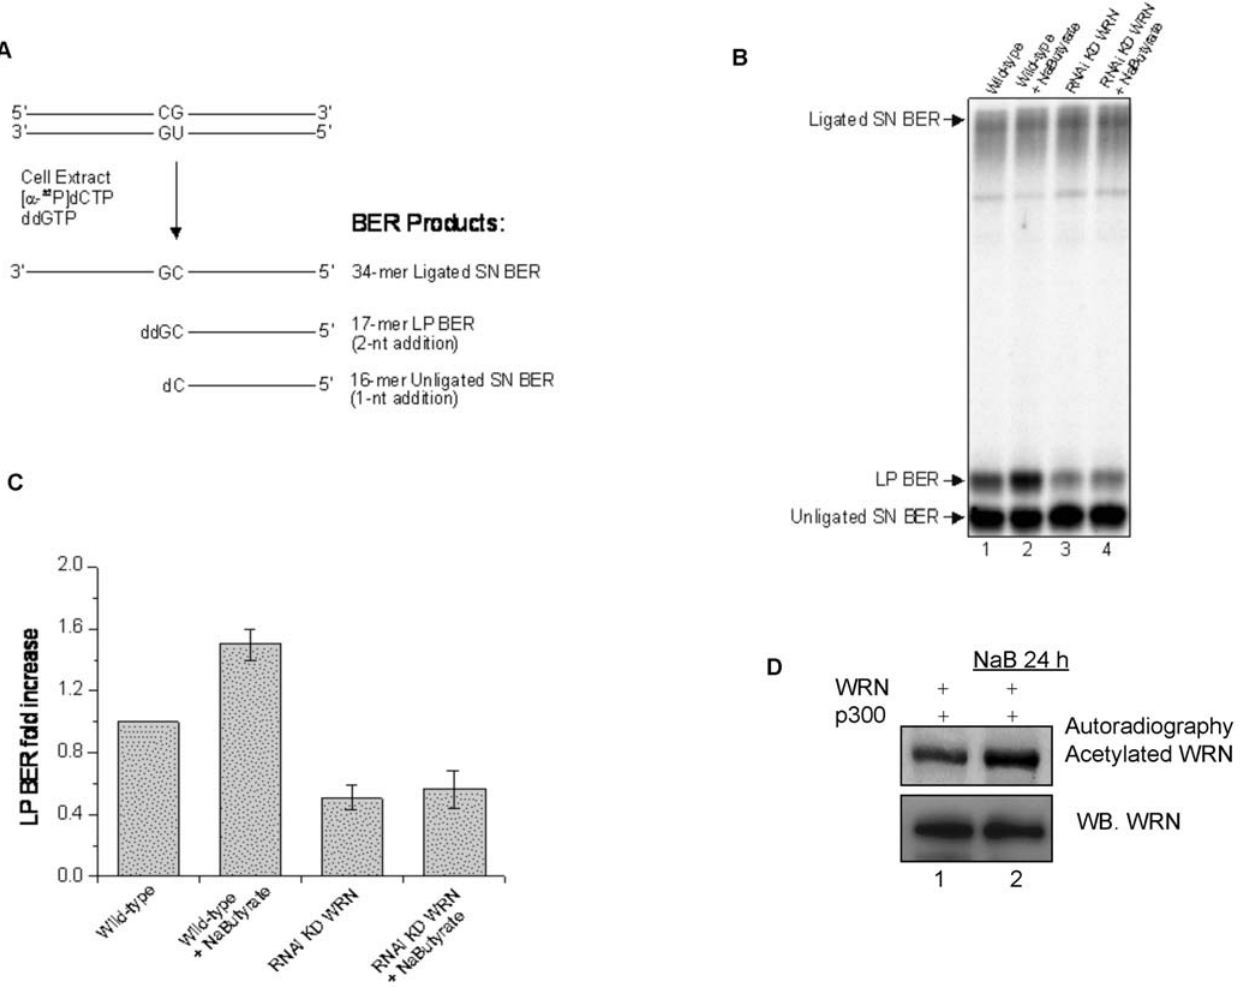
Figure 9. Sodium butyrate treatment enhances LP BER. Comparison of uracil-DNA mediated BER in extracts from wild-type (WT) and WRN KD cells treated with or without 5 mM sodium butyrate. (A) Substrate DNA and predicted BER reaction products and intermediates. The sizes of intermediates (LP BER, 2 nt addition; SN or LP BER, 1 nt addition) and complete BER (ligated 34mer SN BER) product are shown. (B) Phosphorimages of denaturing polyacrylamide gels showing in vitro BER products. The reaction conditions and products analyses are described in Materials and Methods. A 34 bp duplex substrate containing a uracil residue at position 16 was incubated with [ 32 P]dCTP and ddGTP and WT or WRN KD cell extracts (with or without treatment with NaB), as indicated. The positions of the BER products are indicated. (C) Quantitation of LP BER products from three different experiments is plotted. (D) Top panel: After transfection, the cells were treated with 5 mM sodium butyrate for 24 h and labeled with 0.5 mCi/ml [ 3 H]sodium acetate for 1 h. [ 3 H]acetate labeled WRN was immunoprecipitated using an anti-WRN antibody and the complex was resolved on SDS-PAGE and analyzed by autoradiography. Lower panel: Western analysis of acetylated samples with anti-WRN antibody.